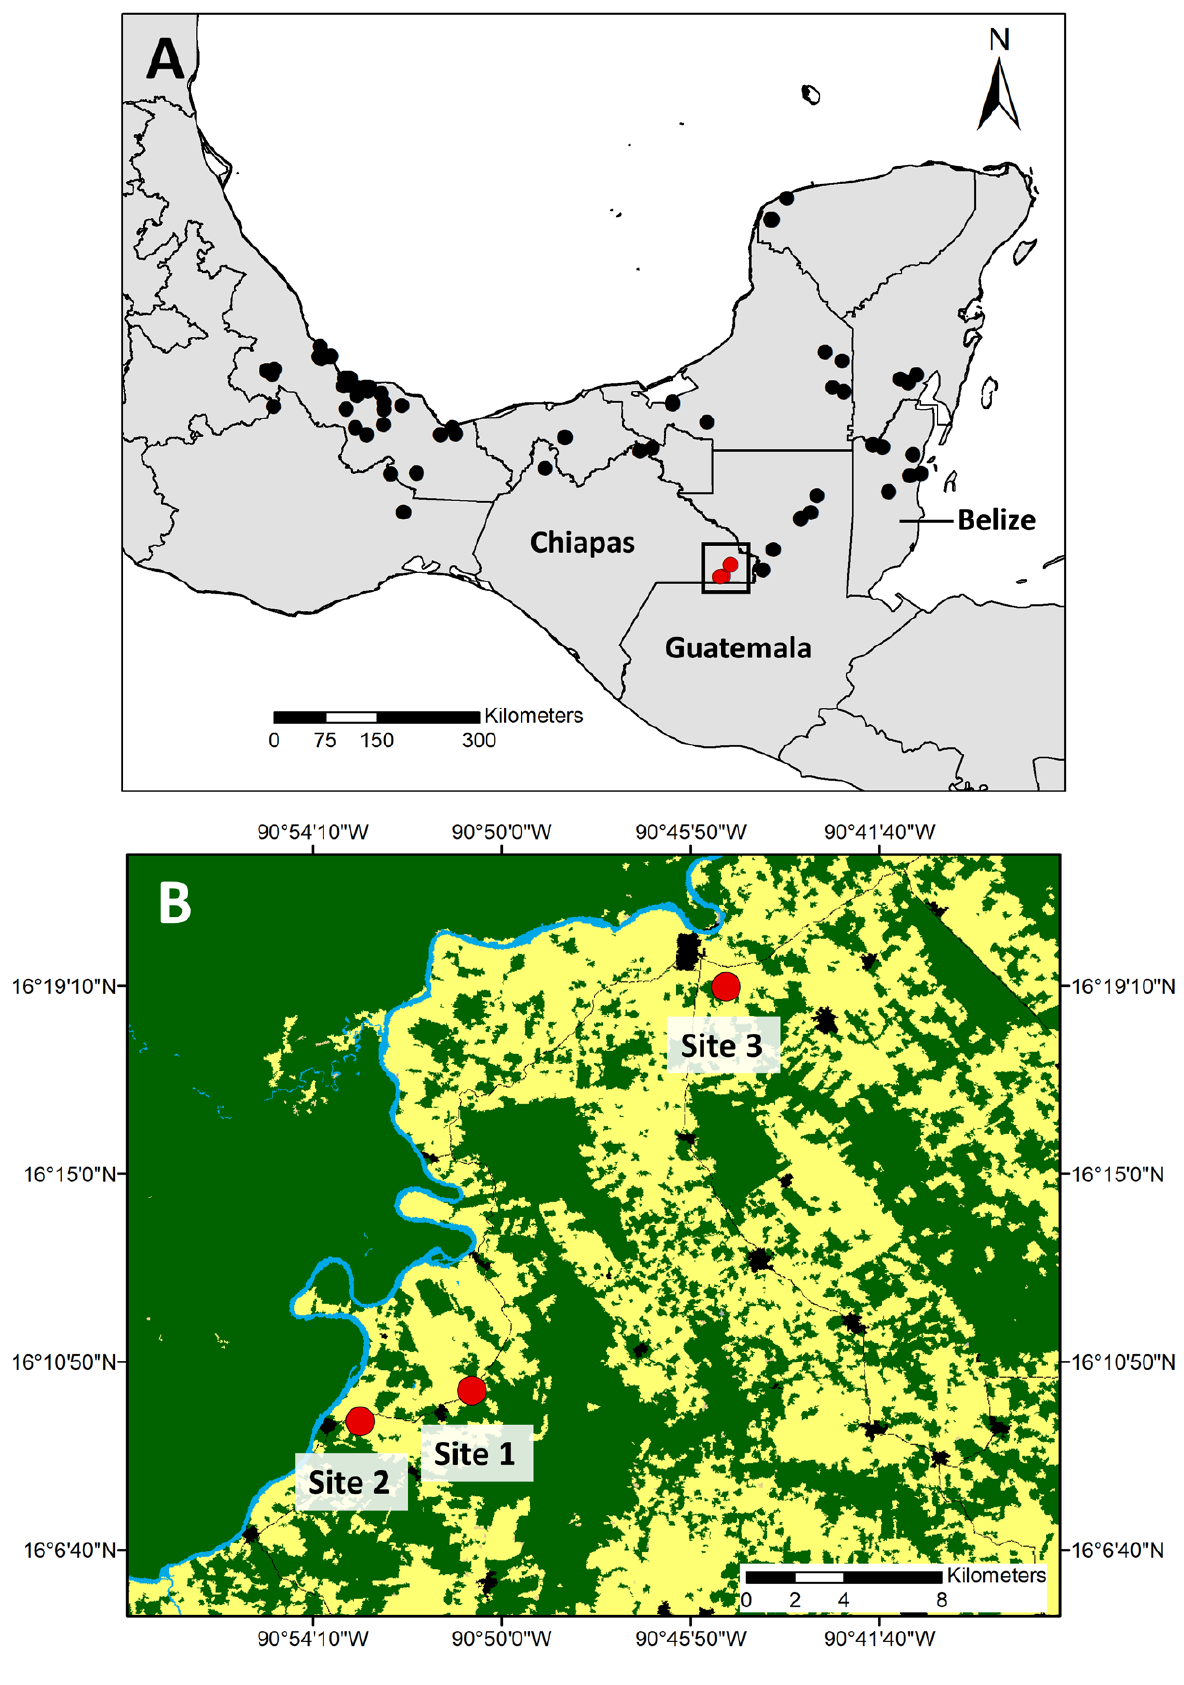
Figure 1. Distribution of Claudius angustatus in Mexico, Belize and Guatemala. A. Geographic distribution of the species based on litera- ture records. B. New records of C. angustatus in the Selva Lacandona, Chiapas. Green coverage = mature forest; light yellow = anthropic matrix; black = human settlements; black dots = literature records; red dots = new